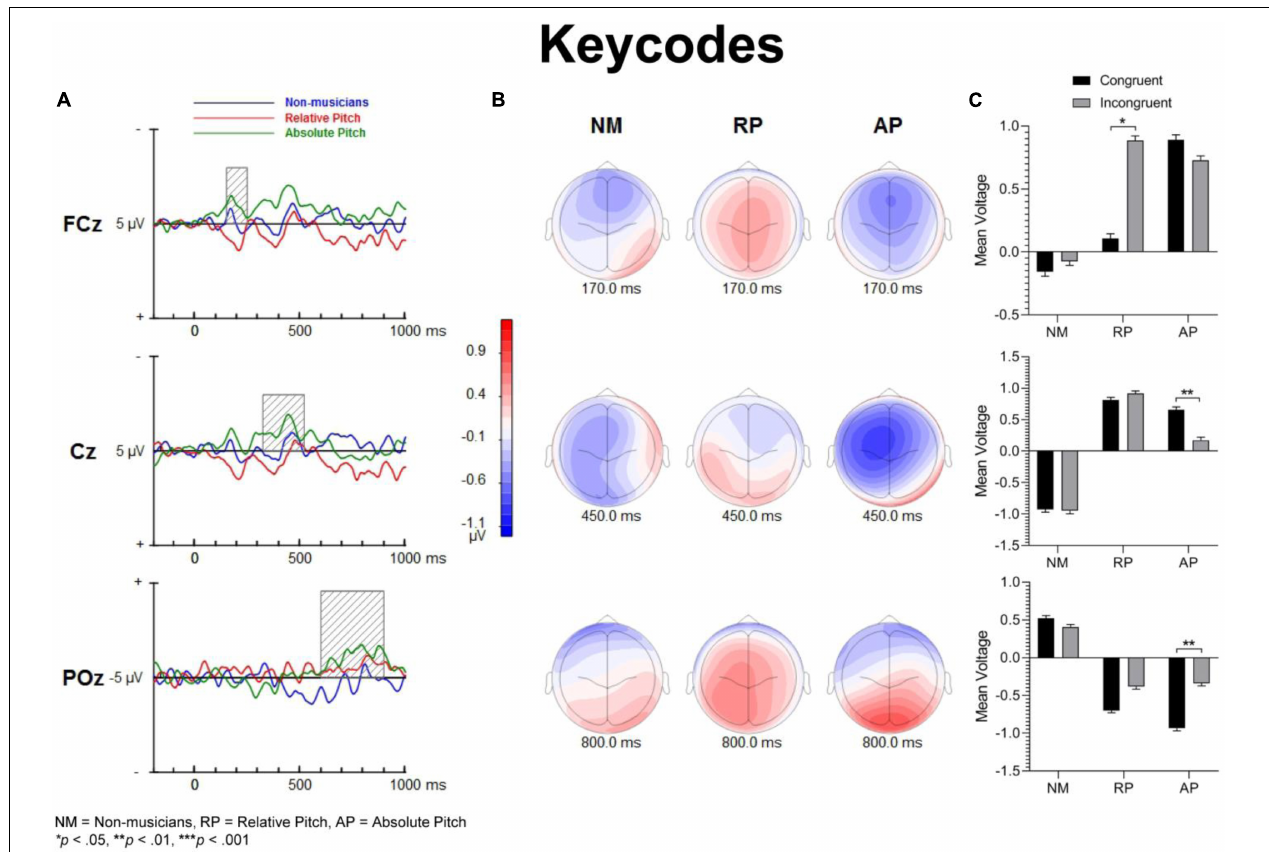
FIGURE 7 | Event-related potential difference waveforms of incongruent minus congruent conditions and topographic maps. Both AP and NM groups show a fronto-central negativity for keycodes task, yet only AP have familiarity and also a significant differences of N450 and posterior positivity for this task. (A) Difference waves and shaded areas displaying temporal windows of interest. (B) Topographic maps show fronto-central negativities at 170 and 450 ms along with a posterior positivity at 750 ms post-stimulation. (C) Bar graphs showing group mean event-related potential amplitude for the P200 (top panel), N450 (middle panel) and LPC (bottom